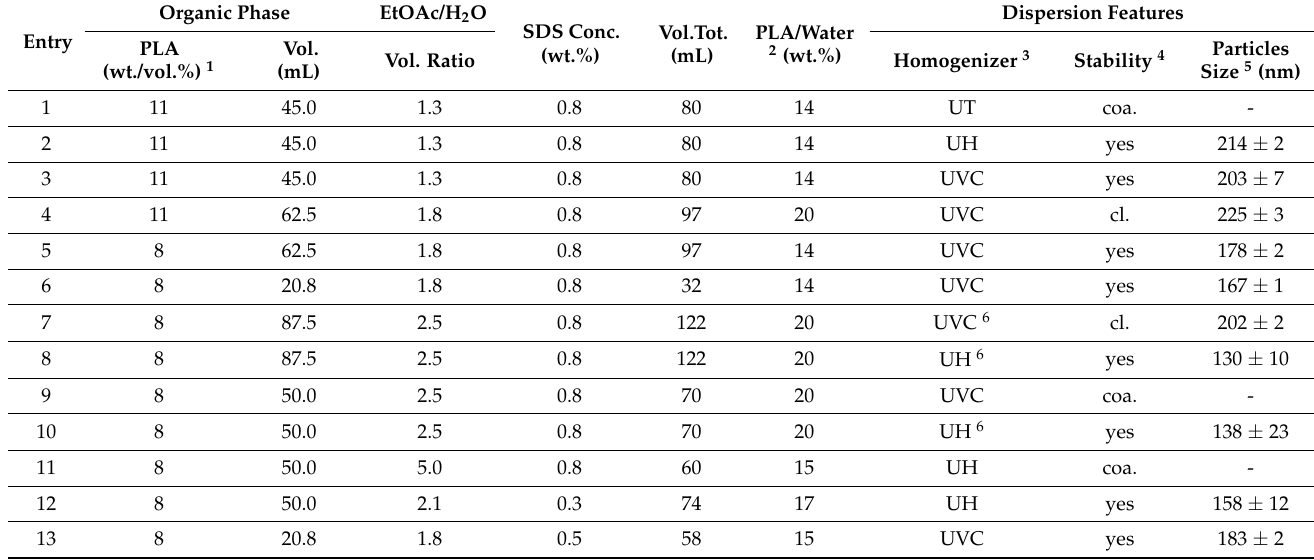
Table 1. Experimental conditions adopted to prepare ethyl acetate-(EtOAc) in-water PLA dispersions with SDS as surfactant and starch as